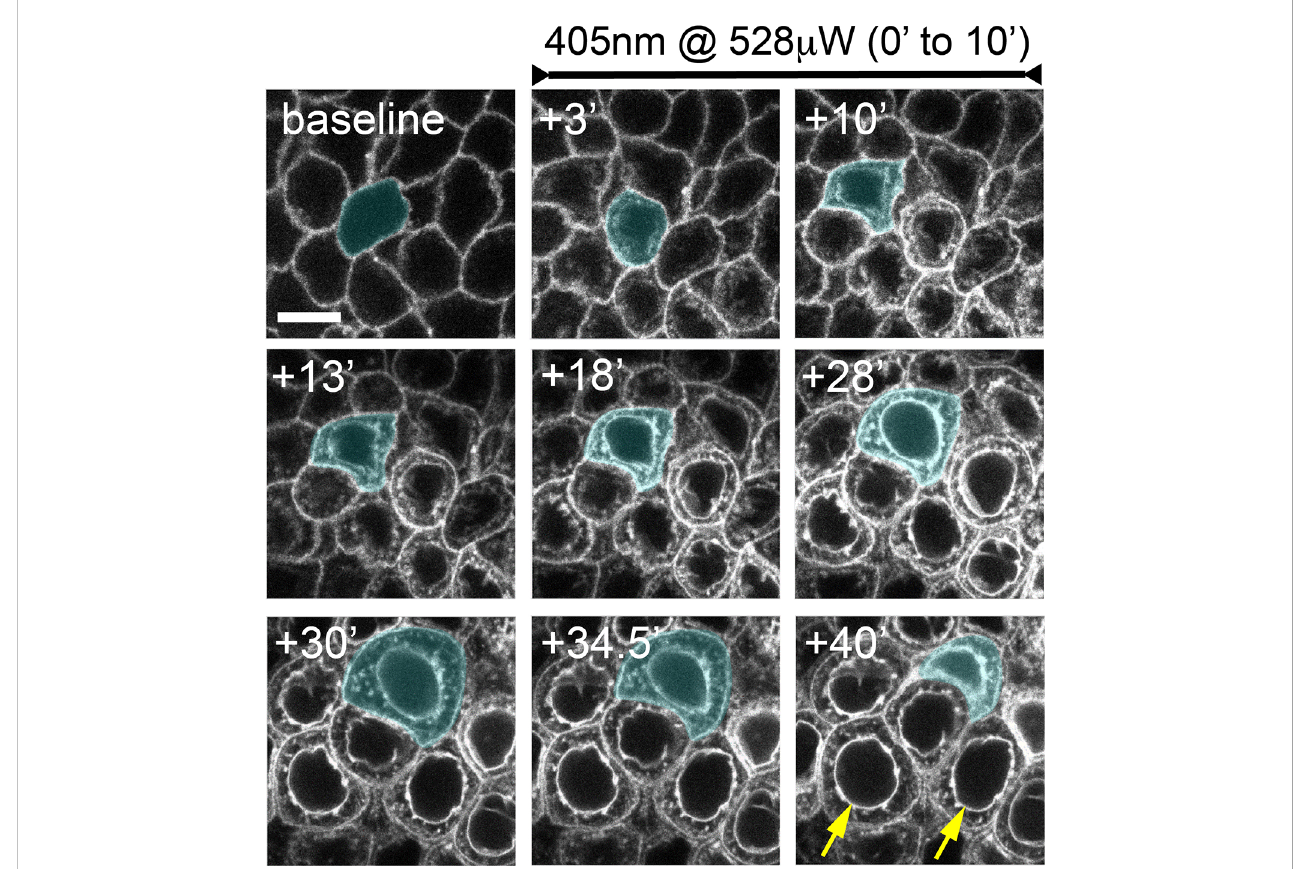
FIGURE 3 Confocal laser scanning microscopy-induced basal epithelial cell microdamage. Corneas were imaged for 30 minutes using the 488 nm laser line at low-power (18 m W) which allowed for stable imaging of SGC5 dye-labelled cell membranes. The basal epithelium was then co-scanned with a 405 nm laser (528 m W) for 10 minutes. Within 3 minutes, fl uorescence was now observed within cells, and membrane fl uorescence increased. Laser-damaged epithelial cells began swelling followed by contraction within 40 minutes of the onset of the 405 nm laser. A cell undergoing swelling (+10 ’ to +30 ’ ) and contraction (+34.5 ’ to +40 ’ ) is shaded blue. The yellow arrows in the bottom right panel indicate presumptive nuclear membrane labeling. Times indicated are in minutes following onset of 405 nm laser scanning. Scale bar =